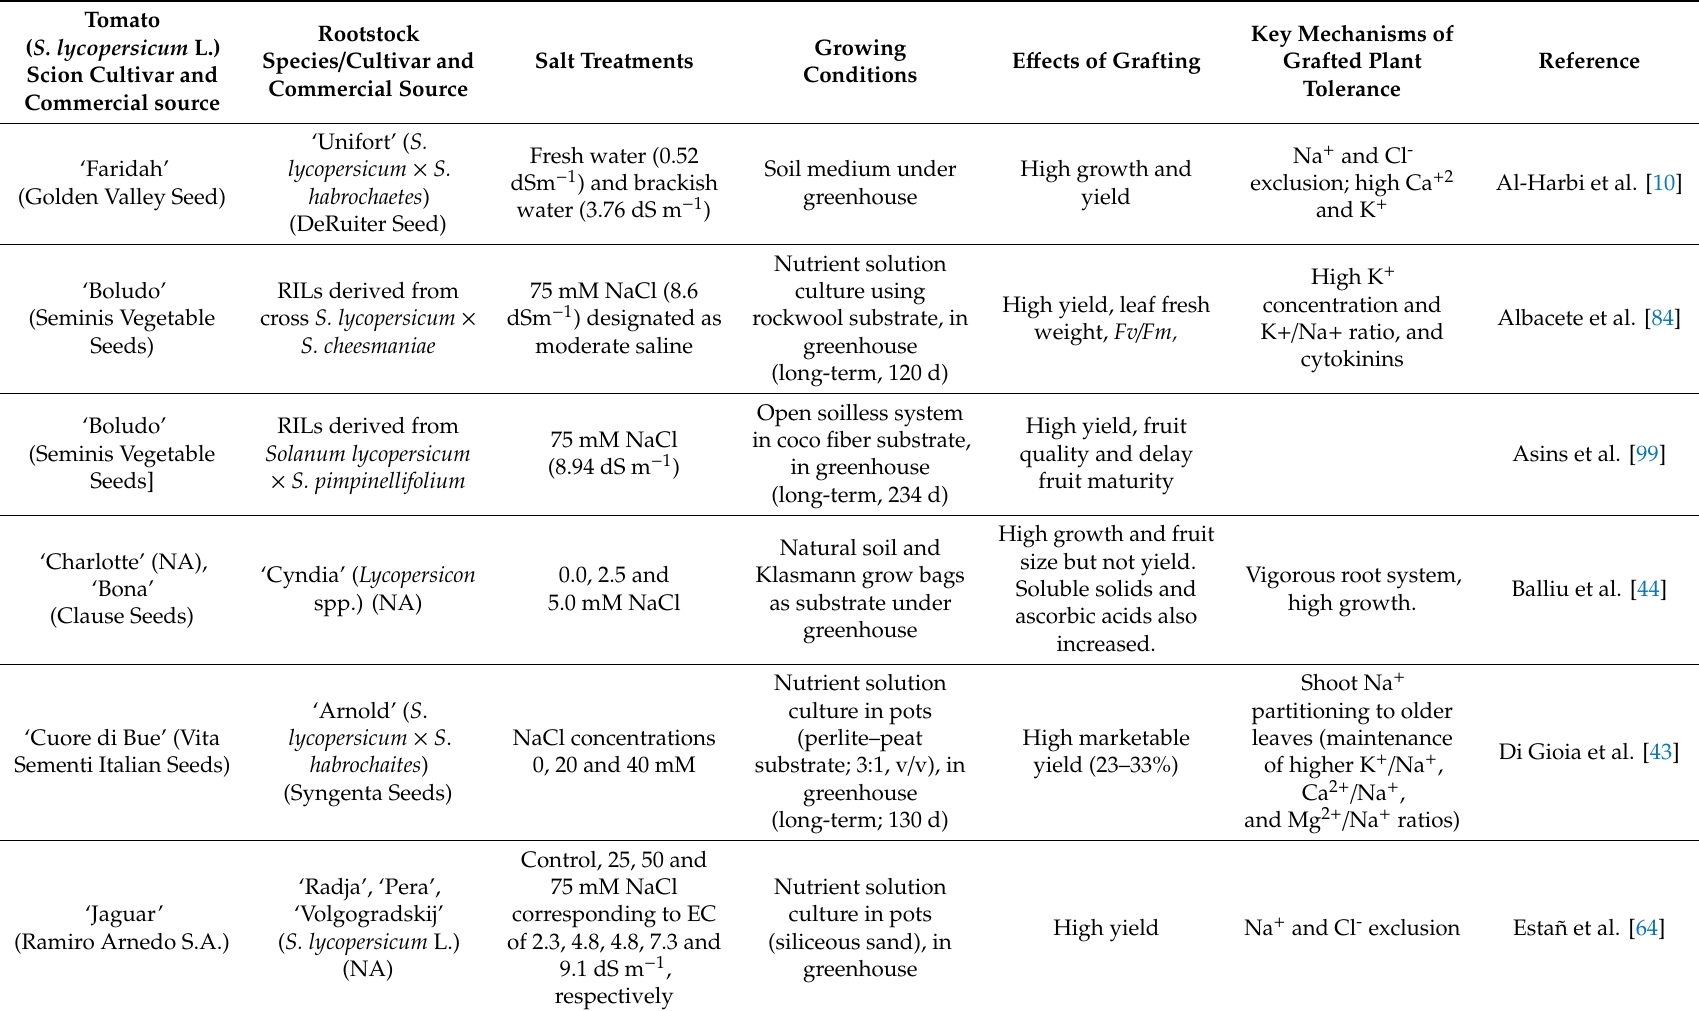
Table 1. Selected examples of grafting combinations to improve salt stress tolerance in